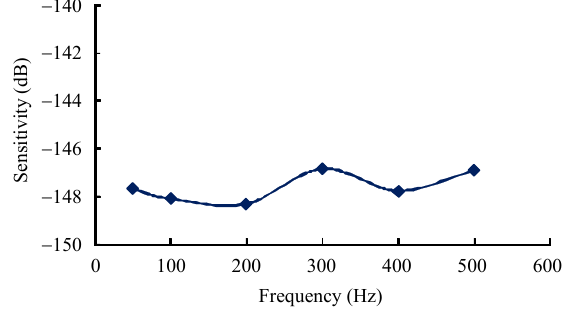
Fig. 6 DAS frequency response